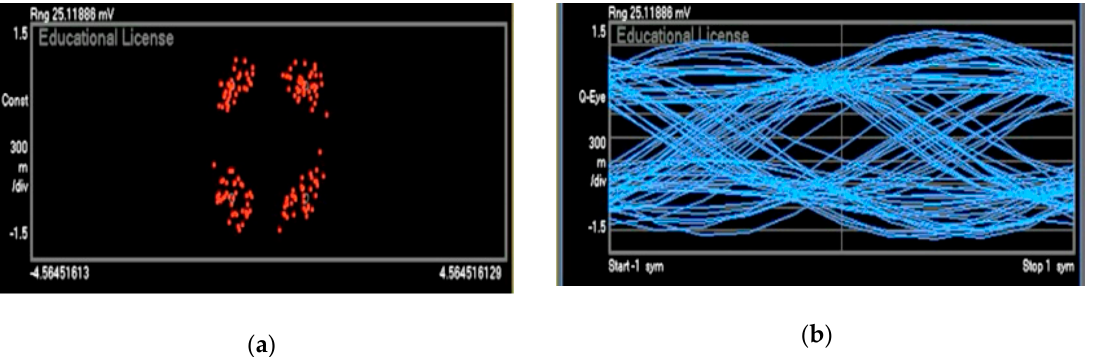
Figure 4. Real-time received QPSK signal reconstruction using VSA code for transmitted 1 Vpp PRBS signal: ( a ) IQ constellation and ( b ) eye pattern.